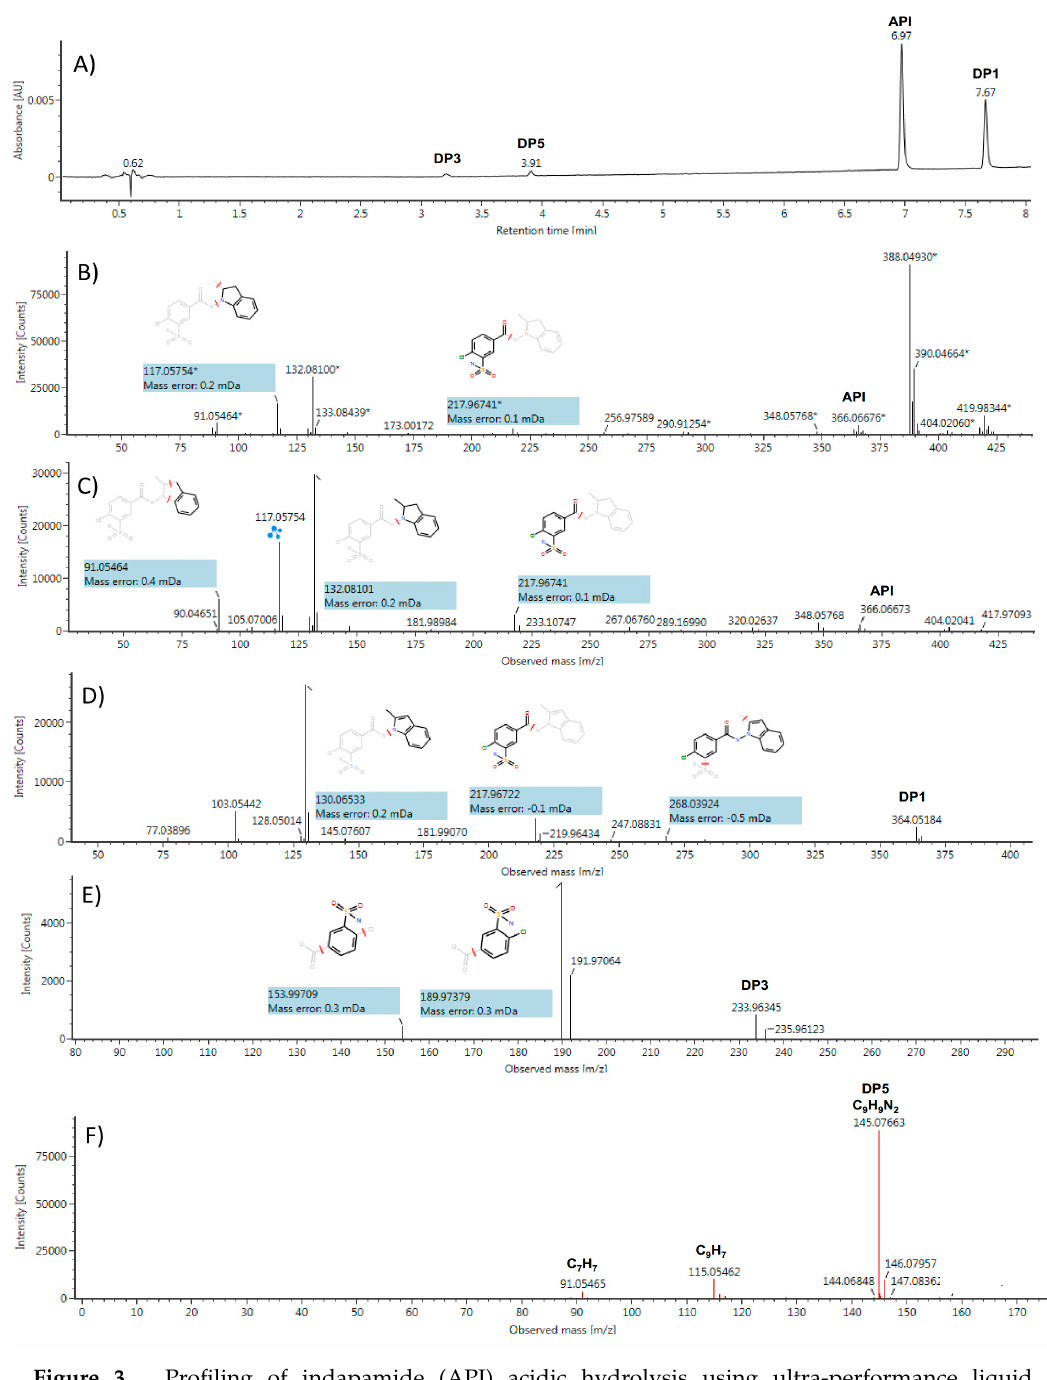
Profiling of indapamide (API) acidic hydrolysis using ultra-performance liquid chromatography / ultraviolet-ESI-high resolution mass spectrometry (UPLC / UV-ESI-HRMS): ( A ) UV chromatogram at 275 nm; ( B ) high-energy (HE) ESI + spectrum of API without drift time filtering; ( C ) HE ESI + spectrum of API with drift time filtering; ( D ) HE spectrum of DP1 in ESI + with drift time filtering; ( E ) HE spectrum of DP3 in ESI - with drift time filtering; and, ( F ) HE ESI + spectrum of DP5 with drift time filtering.